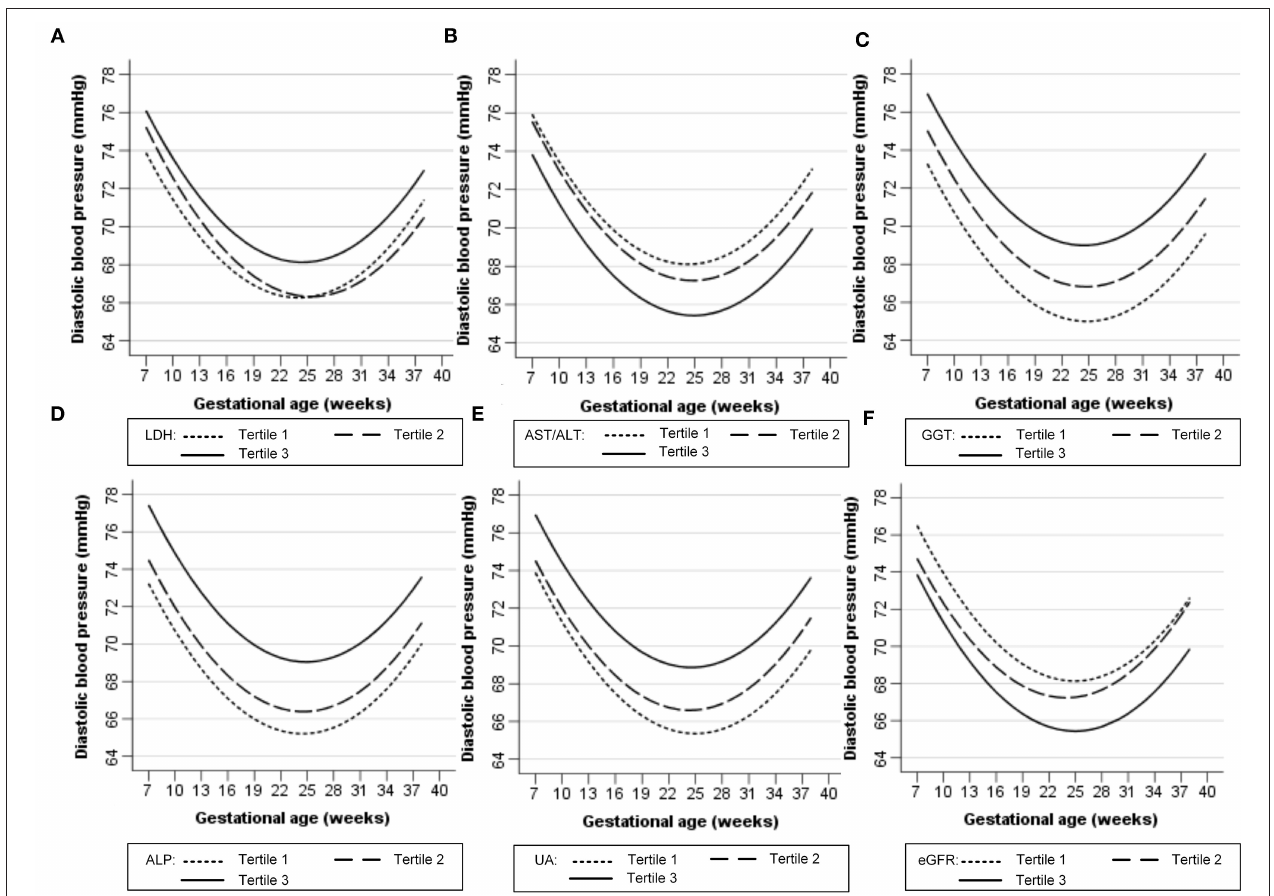
FIGURE 2 | Longitudinal trend of diastolic blood pressure change with gestational age vs. early-pregnancy biomarkers levels, predicted by linear mixed-effects regression models. (A) lactate dehydrogenase (LDH); (B) aspartate aminotransferase to alanine aminotransferase ratio (AST/ALT); (C) gamma-glutamyl transpeptidase (GGT); (D) alkaline phosphatase (ALP); (E) uric acid (UA); (F) estimated glomerular filtration rate (eGFR).